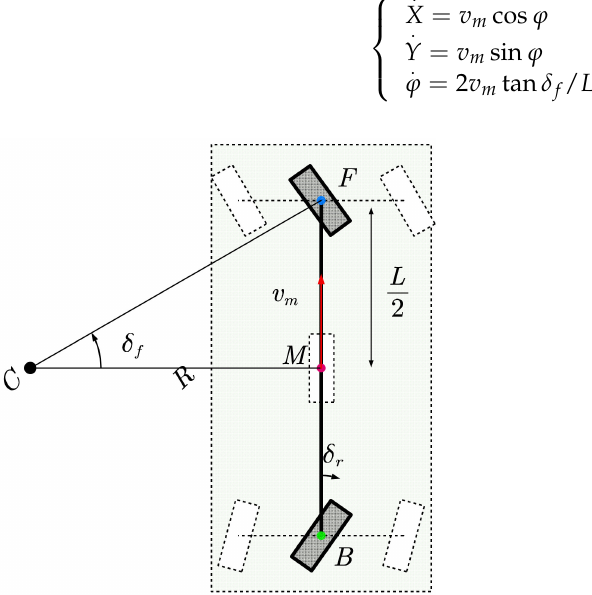
Figure 3. Schematic diagram of the SFRWS kinematics model of the 4WS